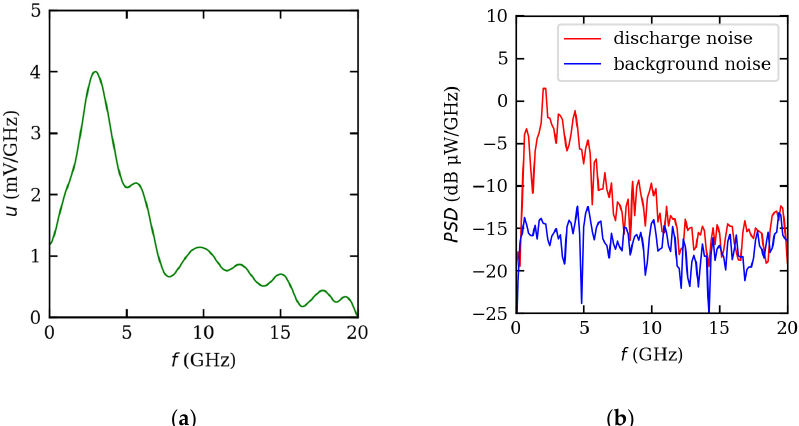
Figure 6. ( a ) Typical voltage spectrum of an individual radiation pulse. ( b ) Power spectral density of a package of UHF-SHF pulses. Background noise presented as a reference was obtained from the sections of the antenna waveforms taken before the beginning of the streamer discharge process. The anode voltage is 38